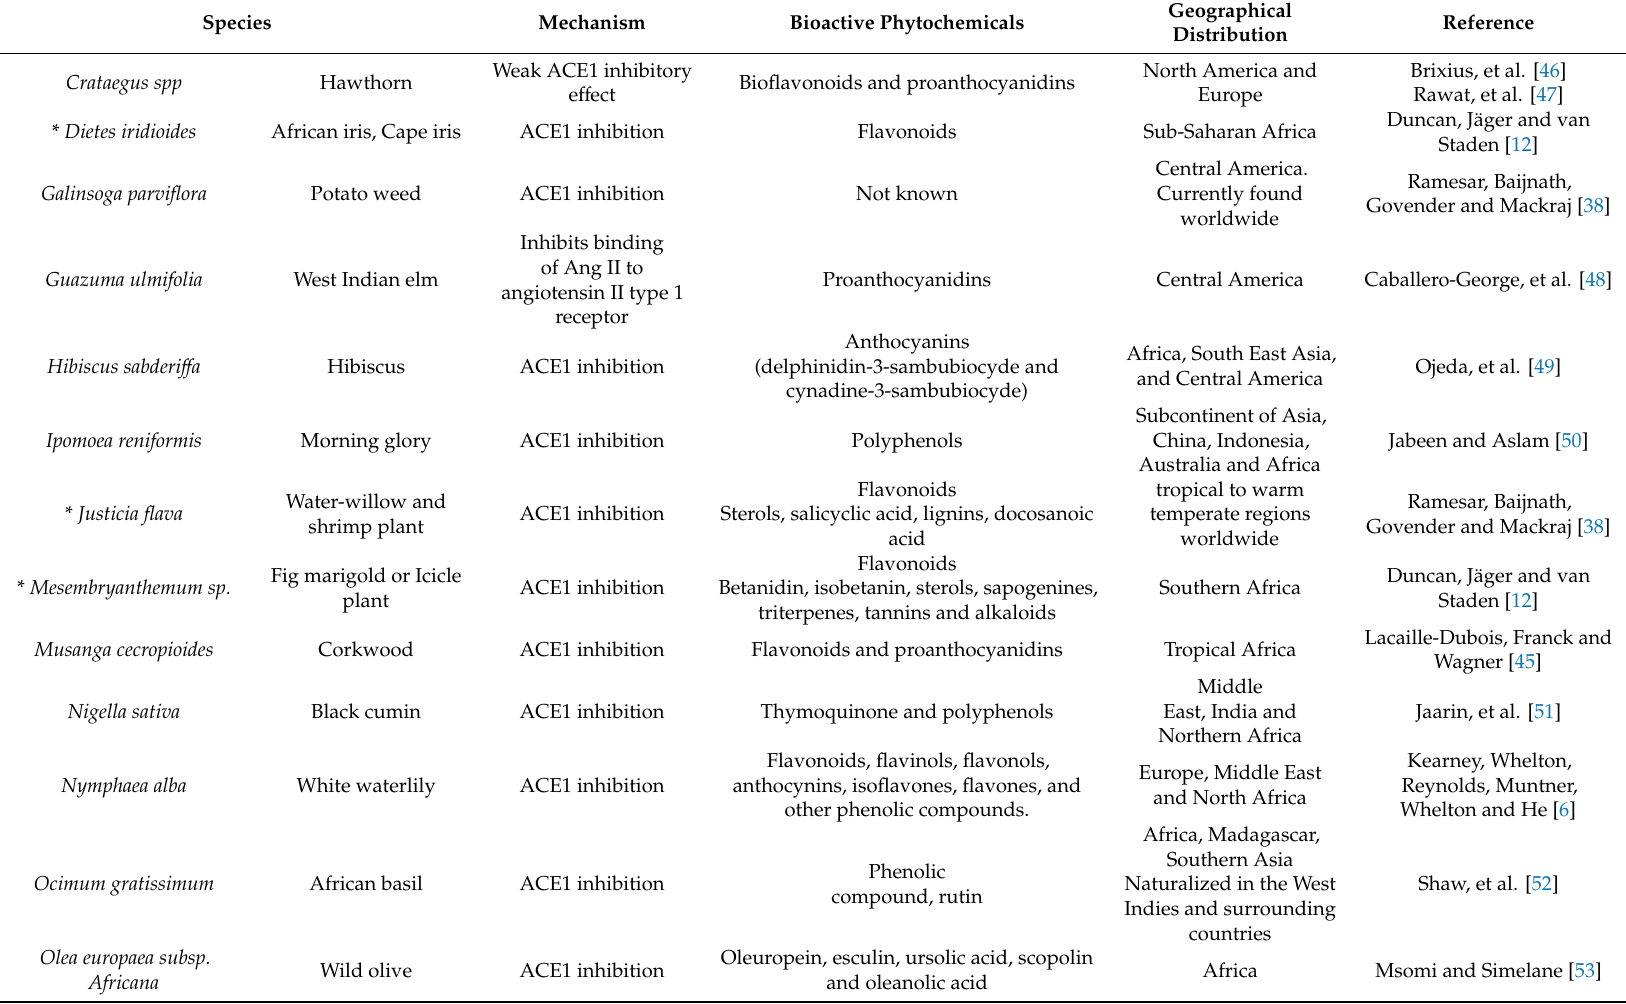
Fig marigold or Icicle